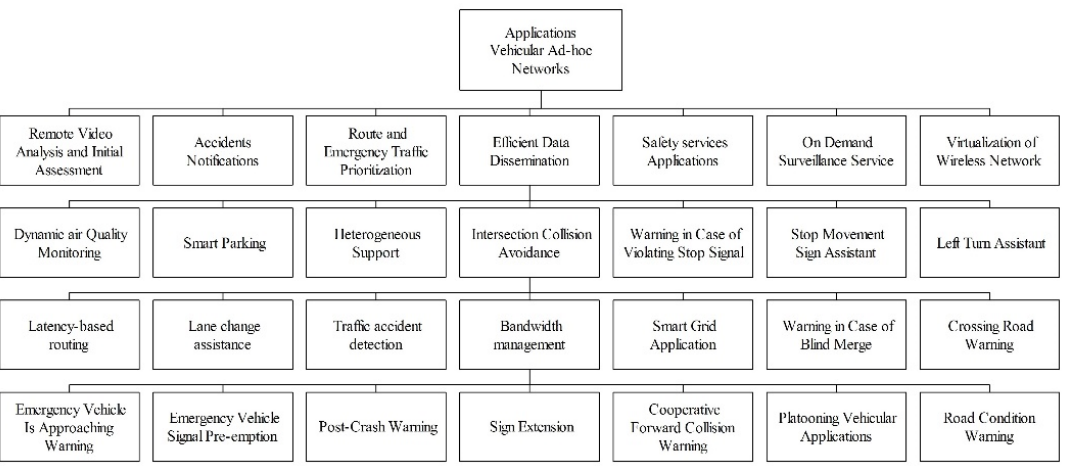
Figure 27. The taxonomy of the SDN-based VANET applications.